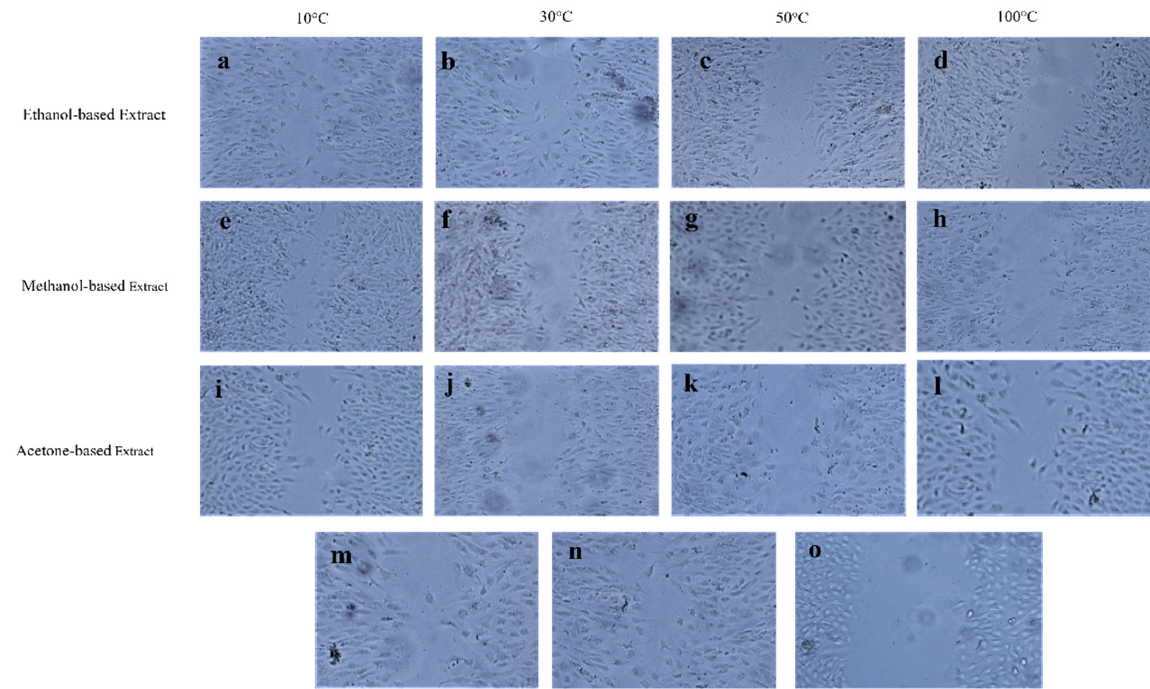
Figure 6. Wound healing activity of 12 different M. oleifera extracts at 16 h of incubation after the wound creation. ( a – d ) represent ethanol-based extract-treated cells, ( e – h ) are methanol-based extract-treated cells, and ( i – l ) are acetone-based extract-treated cells. ( m – n ) represents PBS and PDGF (used as negative and positive controls)-treated cells. ( o ) represents the scratch width at 0 h.